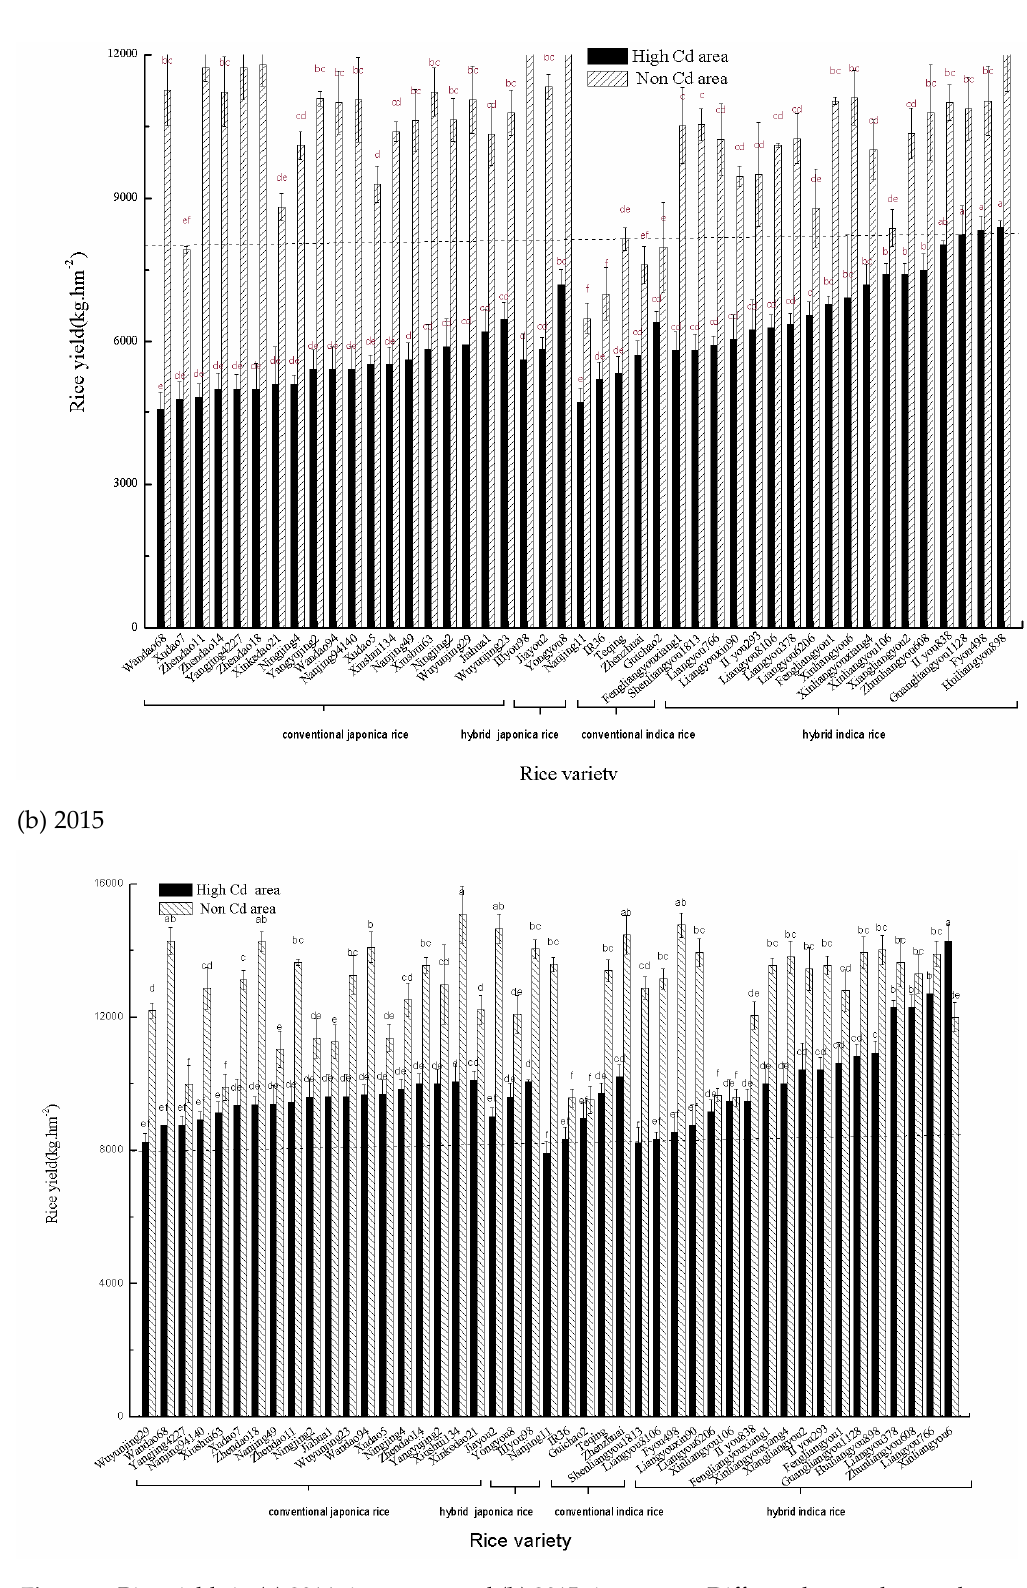
Figure 2. Rice yields in ( a ) 2014 rice season and ( b ) 2015 rice season. Different letters above columns indicate significant difference among varieties at 0.05 level.